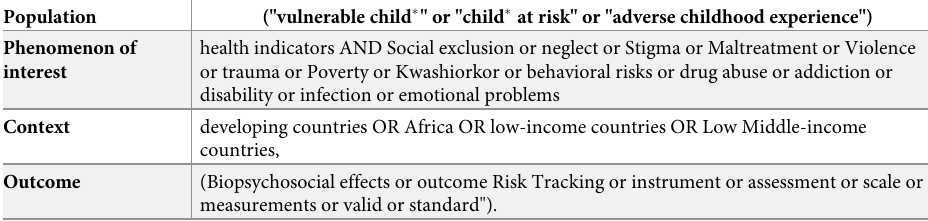
Table 1. PICO (Population, Phenomenon of interest, Context,